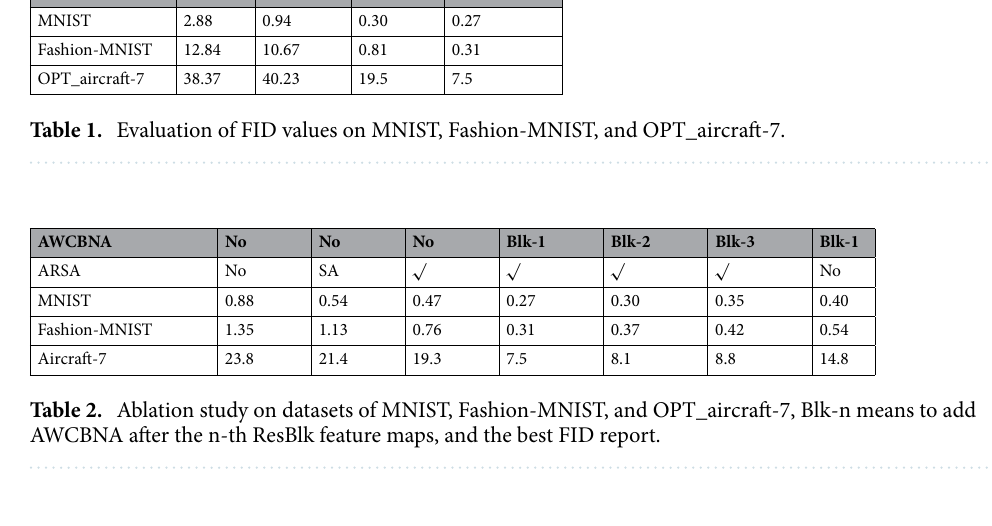
Figure 7. Visual comparison of generated samples on three datasets. ( a ) CGAN 9 . ( b ) ACGAN 10 . From left to right, they are generative samples of MNIST, Fashion-MNIST, and OPT_Aircraft-7 datasets. Method